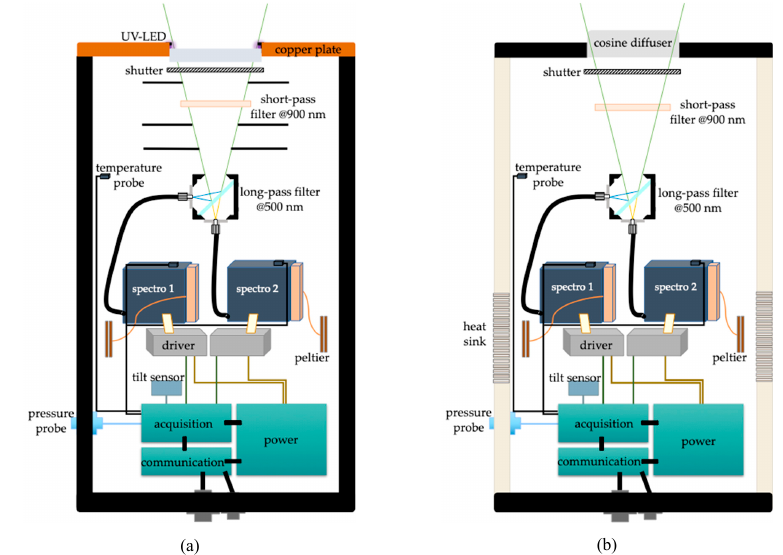
Figure 19. Preliminary design of (a) radiance radiometer and (b) irradiance radiometer.